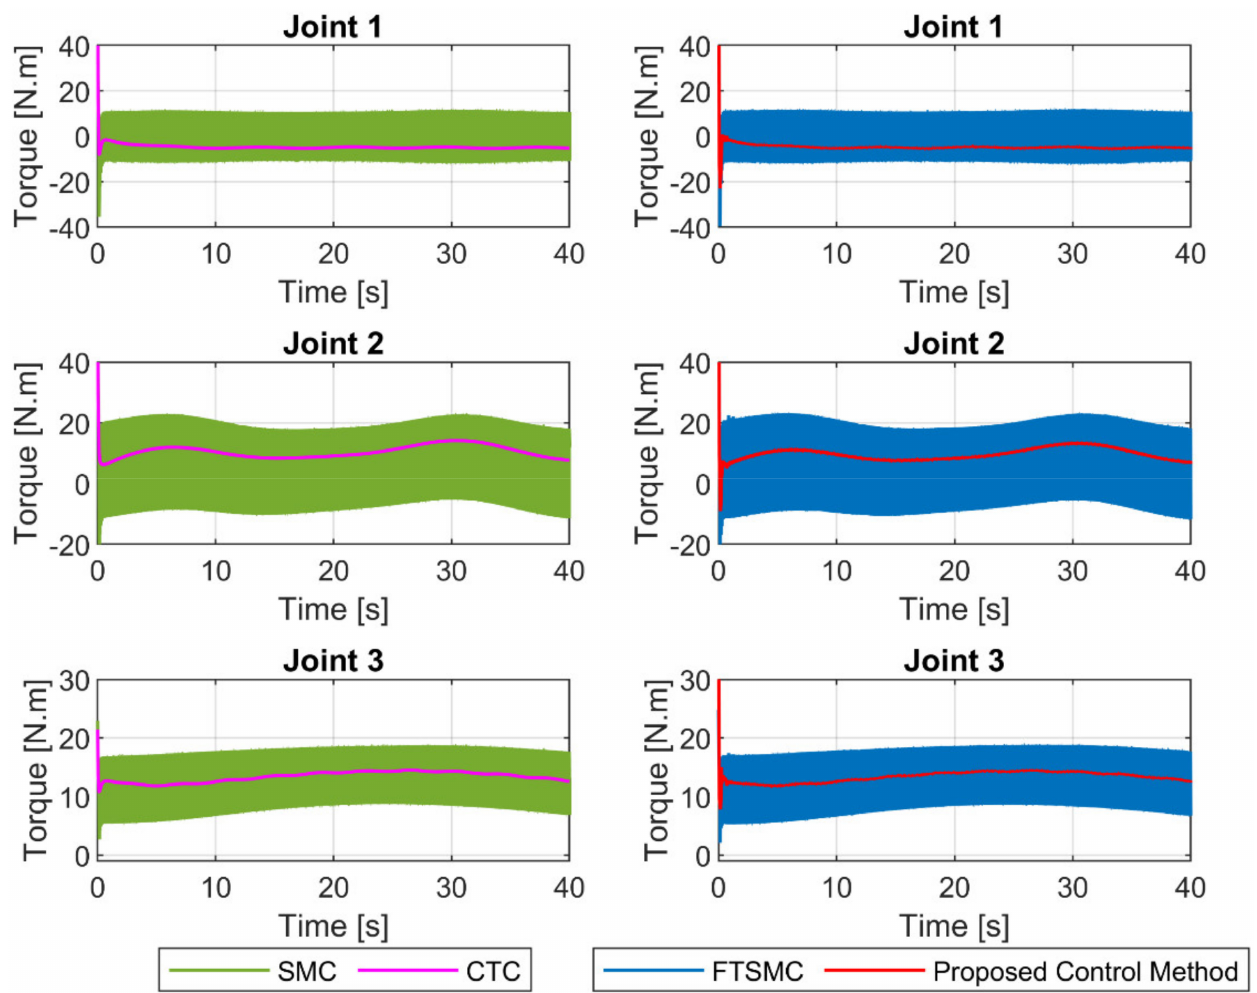
Figure 7. The control input torques at joints of four